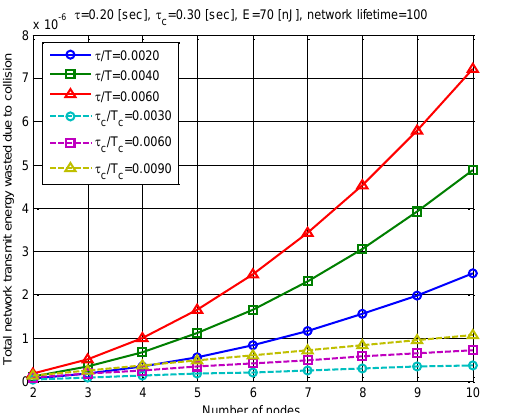
Figure 12. Total network transmit energy wasted due to